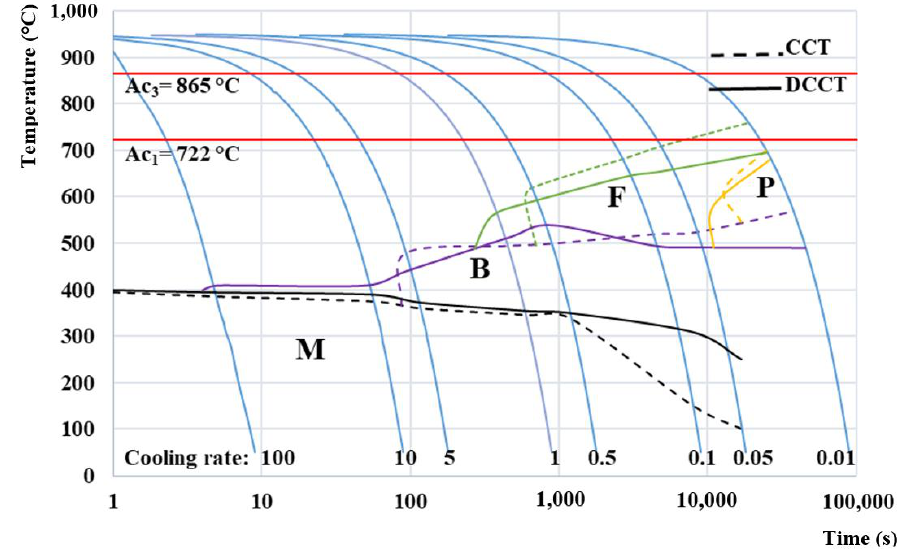
Figure 8. CCT and DCCT diagram of lean medium Mn 0.2C3Mn1.5Si steel.